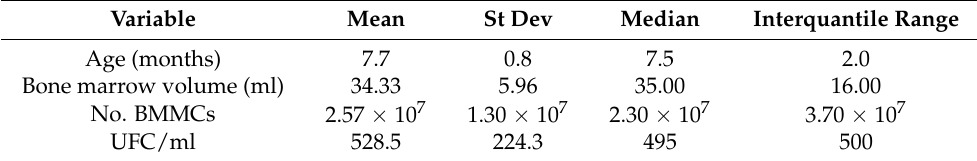
Table 2. BMMCs quantity from the harvesting of bone